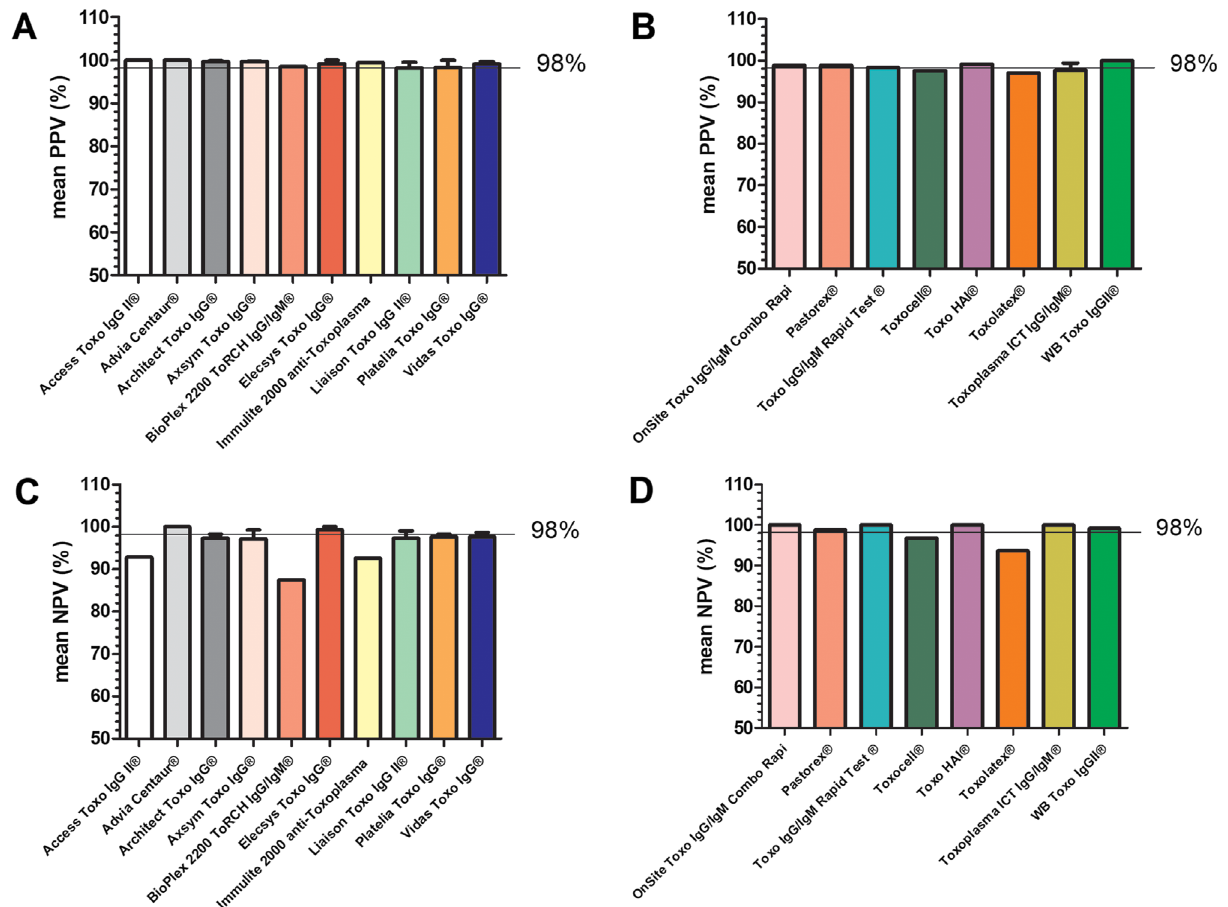
Figure 2. Positive predictive value (PPV) and negative predictive value (NPV) calculated for 10 anti- Toxoplasma IgG EIA assays (A, C) and 8 manual assays (B, D) included in the